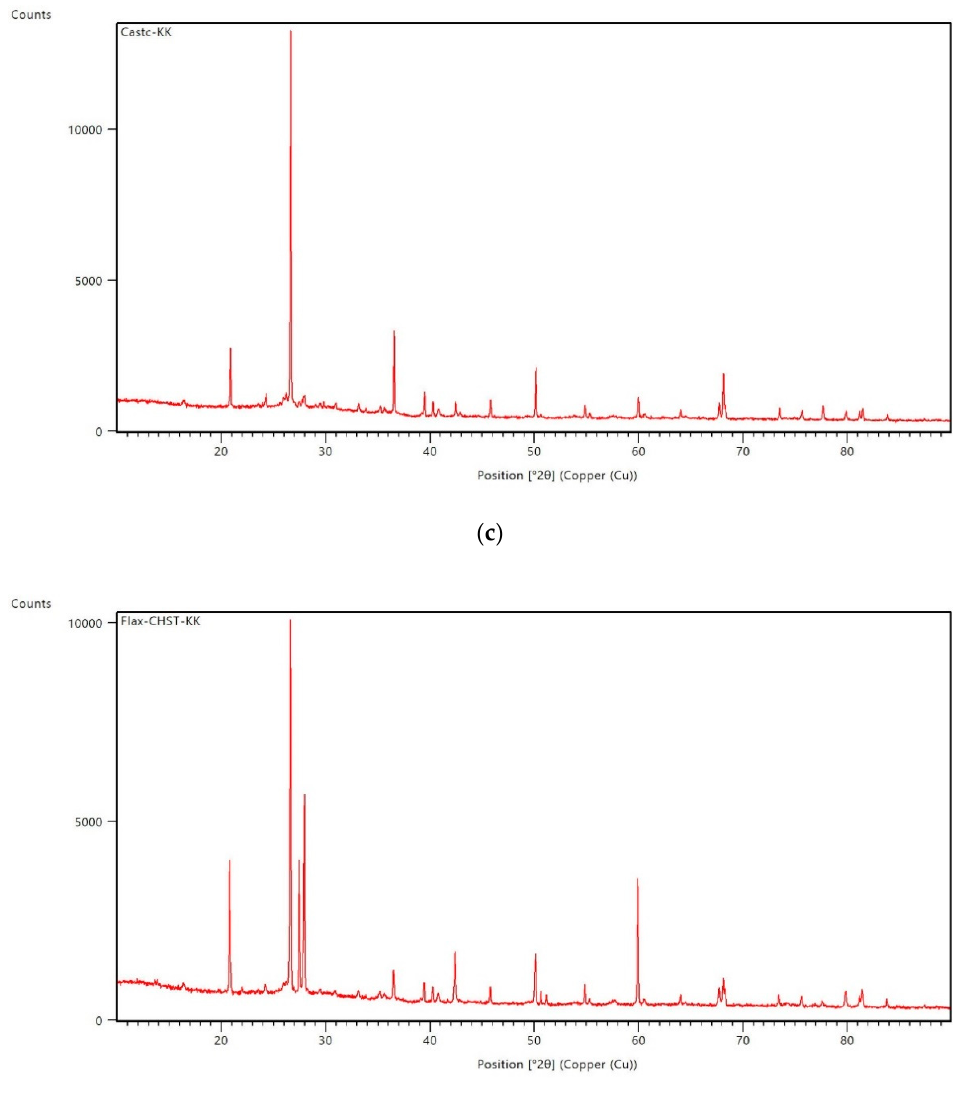
Figure 3. The results of XRD analysis for samples: ( a ) 3DC; ( b ) 3DF; ( c ) CASTC; ( d ) CASTF.